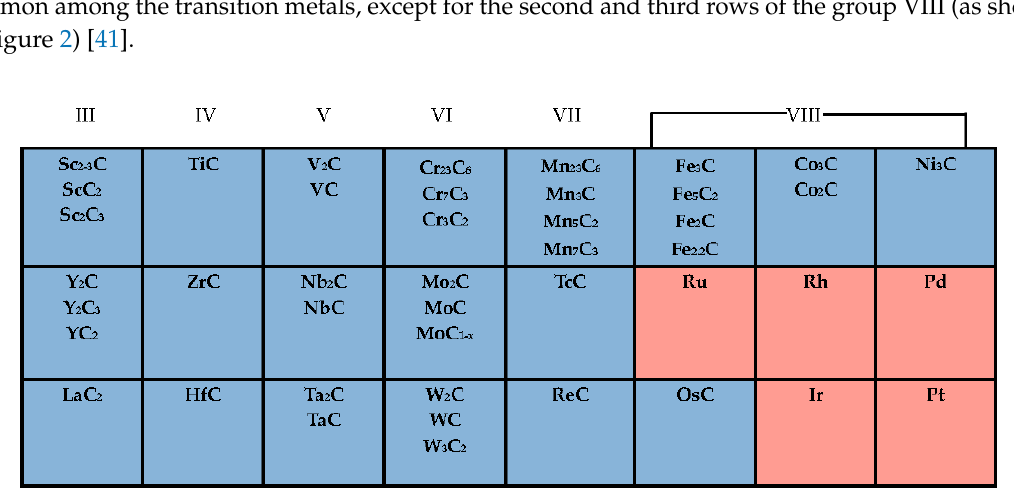
Figure 2. Transition metal carbide formation in periodic table. Blue: Transition metal carbides; Red: elements that do not form carbide.